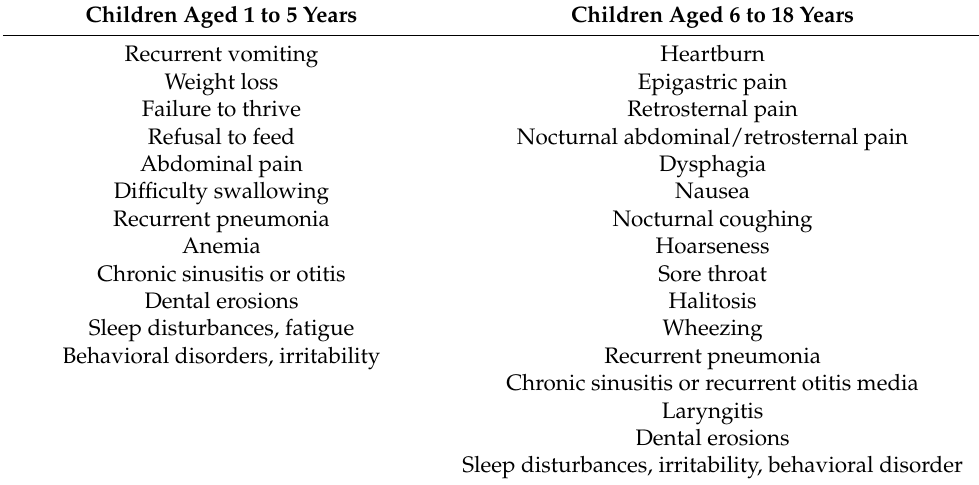
Table 9. GERD signs and symptoms in children by age group